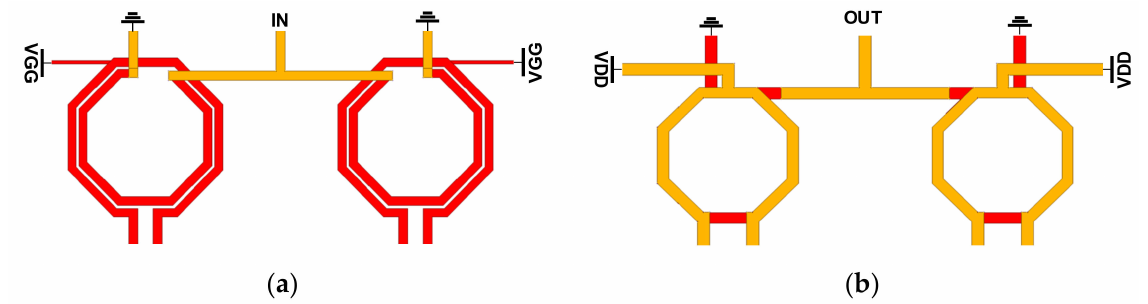
Figure 5. Configuration of ( a ) the divider and ( b ) the combiner at the input and output of the 4-way PA.